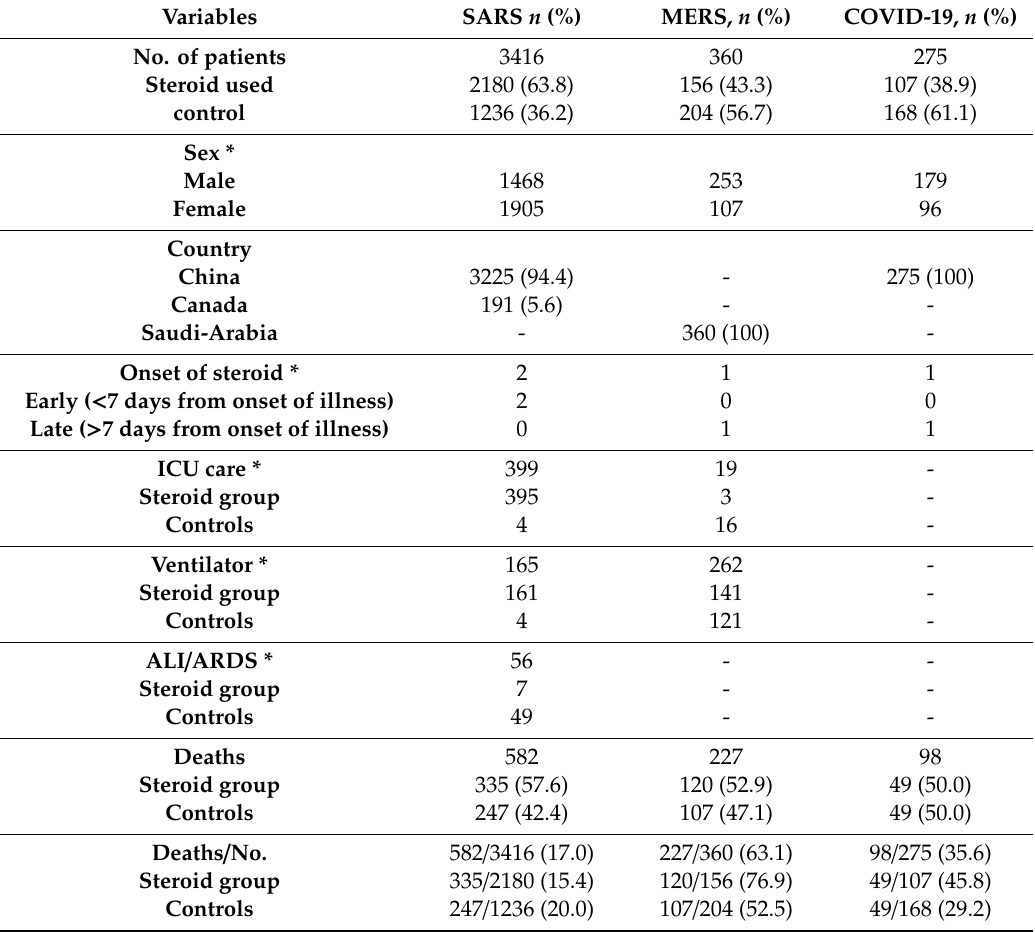
Table 3. Summary of the characteristics of the included